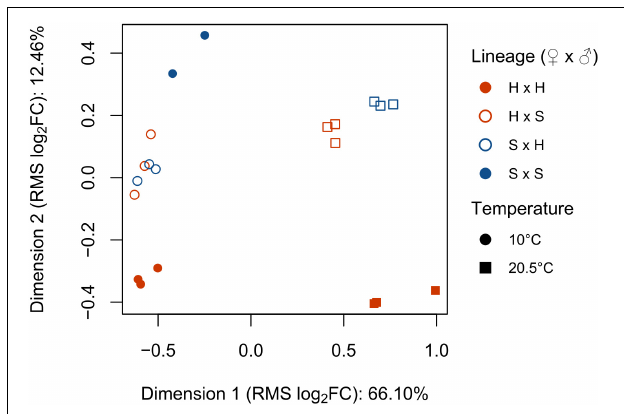
FIGURE 4 | Multidimensional scaling (MDS) plot of gene expression (log counts per million) at 10 and 20.5 ◦ C of Laminaria digitata sporophytes produced by crossing females × males from Helgoland (H) and Spitsbergen (S; n = 3; for S × S at 10 ◦ C, n = 2). Proportion of variance explained is given for each dimension. Distances on the plot correspond to the root-mean-square average log 2 -fold-change (RMS log 2 FC) for all differentially expressed KEGG genes (FDR < 0.01, log 2 FC ≥